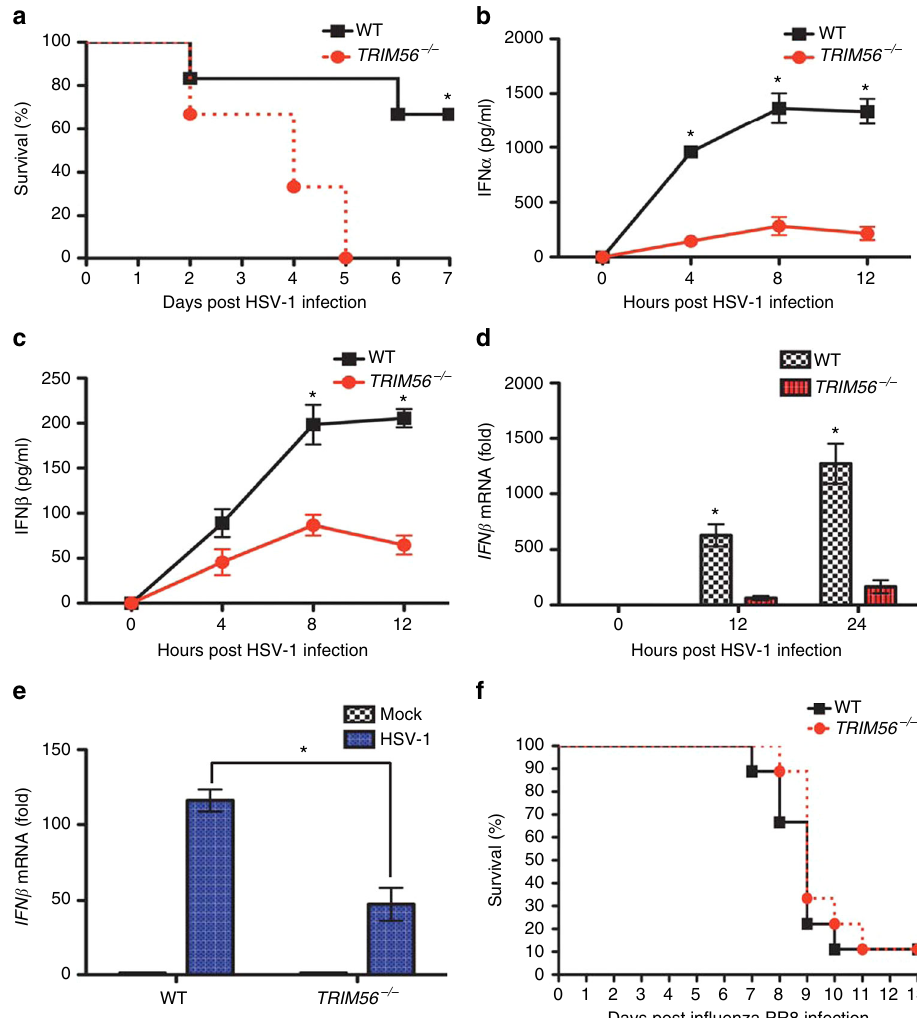
Fig. 5 TRIM56 − / − mice are susceptible to HSV-1 infection but not to IAV infection. a HSV-1 (1.8 × 10 8 pfu/mouse) was injected peritoneally to WT or TRIM56 − / − mice ( n = 6 each). Survival rates were monitored for 7 days. b , c Sera were collected from WT or TRIM56 − / − mice injected with HSV-1 at the indicated time points, and IFN α or IFN β concentration was measured by ELISA ( n = 3 each at each time point). Total peritoneal cavity cells ( d ) and peritoneal macrophages ( e ) were isolated from WT or TRIM56 − / − HSV-1-infected mice ( n = 3 for each time point). IFN β mRNA levels in these cells were measured using RT-PCR. f In fl uenza PR8 (1000 pfu/mouse) was administered intranasally to WT or TRIM56 − / − mice ( n = 9 each). Survival rates were monitored for 13 days. Error bars indicate mean ± s.d. * P < 0.05, Student ’ s t -test. Data in a – f are representative of two independent experiments. Error bars in b – e indicate mean ± s.d. of n = 3. * P < 0.05, versus control using Student ’ s t -test ( a – e − / − TRIM56 mice had signi fi cantly lower IFN β mRNA levels upon HSV-1 infection compared to those from WT mice ( p < 0.05, − / − Fig. 5e). In contrast to the previous in vitro study 29 , TRIM56 mice ( n = 9) showed nearly no difference from WT mice (n = 9) in response to in vivo IAV PR8 infection; both mice rapidly lost weight and died over a period of 11 days (Fig. 5f and Supple-